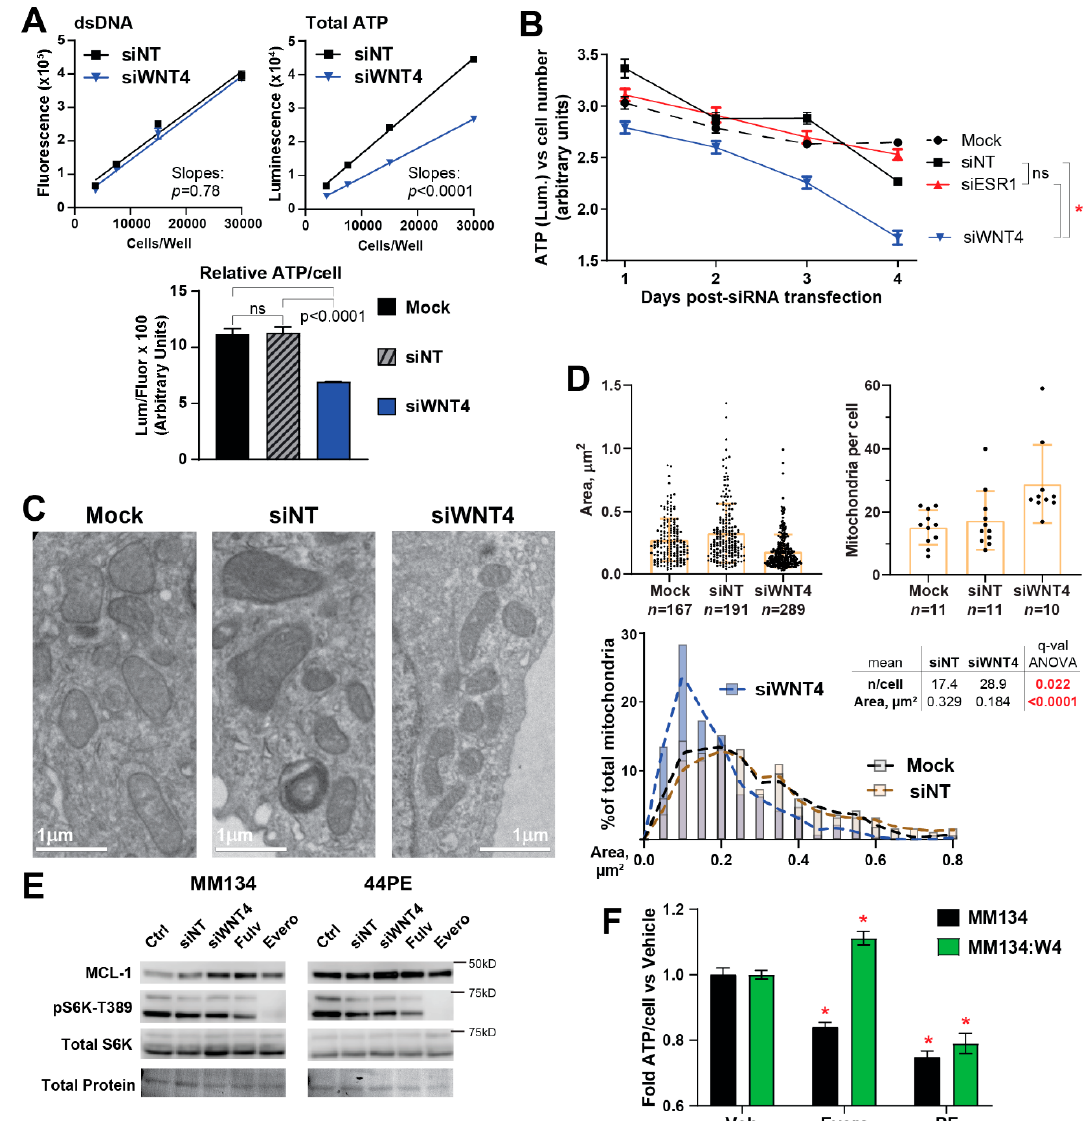
Figure 4. WNT4 knockdown compromises cellular metabolism and drives mitochondrial fragmentation. ( A ) MM134 cells were transfected with siRNA as indicated, 48 h later cells were harvested and re-plated in a two-fold serial dilution in technical quadruplicate. Then, 24 h later (72 h post-transfection) dsDNA and total ATP were quantified from separate samples. Bar graph at bottom represents 30 k / well data from standard curves (mock excluded from standard curves for clarity). Comparisons with ANOVA + Tukey correction. ( B ) MM134 cells transfected as indicated, with dsDNA and total ATP quantified at the indicated time from matched samples. Cell number was determined by interpolating dsDNA fluorescence vs. a standard curve, and total ATP (luminescence) was normalized vs. cell number. Comparisons by two-way ANOVA; α = 0.01. * p < 0.0001. ( C ) MM134 cells were fixed for transmission electron microscopy 72 h post-transfection. Representative images of mitochondrial morphology shown. ( D ) Mitochondrial dimensions were quantified from TEM images using ImageJ (see Section 4). Box-and-whiskers represent mean ± SD. Histogram is derived from area data shown as dot plot at top. ( E ) Cells in full serum were either reverse transfected with the indicated siRNA for 48 h, or treated with 100 nM fulvestrant, or 100 nM everolimus for 24 h. S6K phosphorylation (mTOR target site T389) shown as positive control for mTOR inhibition by everolimus. Total protein detected with Ponceau staining. ( F ) MM134 were treated with 100 nM everolimus or 30 µ M PF-4708671 for 72 h; ATP and dsDNA were quantified as above. * q < 0.05 vs. vehicle by two-way